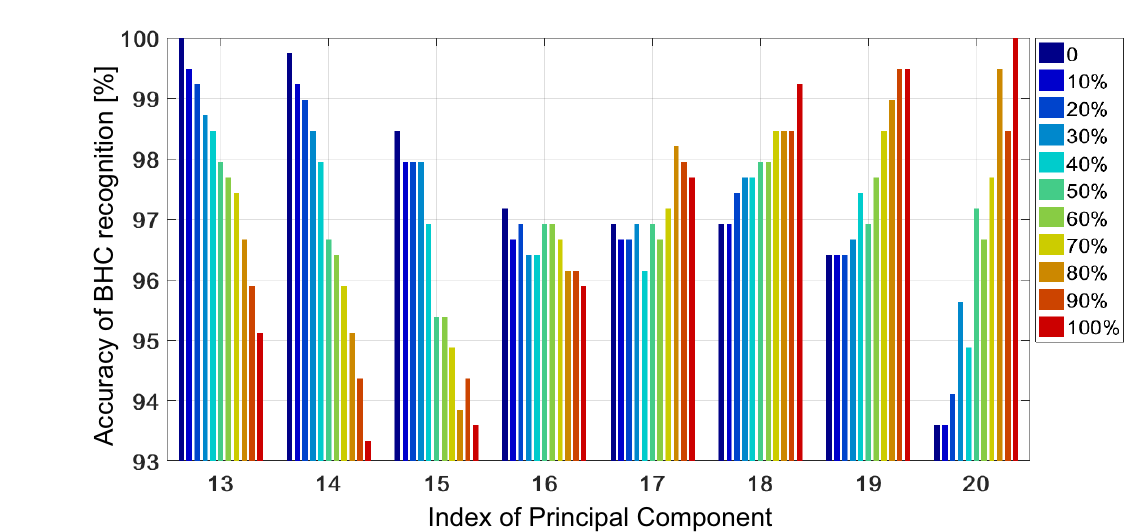
Figure 6. Accuracy of BHC recognition obtained with non-adaptive KSVM versus the number of PCs (from 13 to 20) at various contributions of outer-class samples in the test